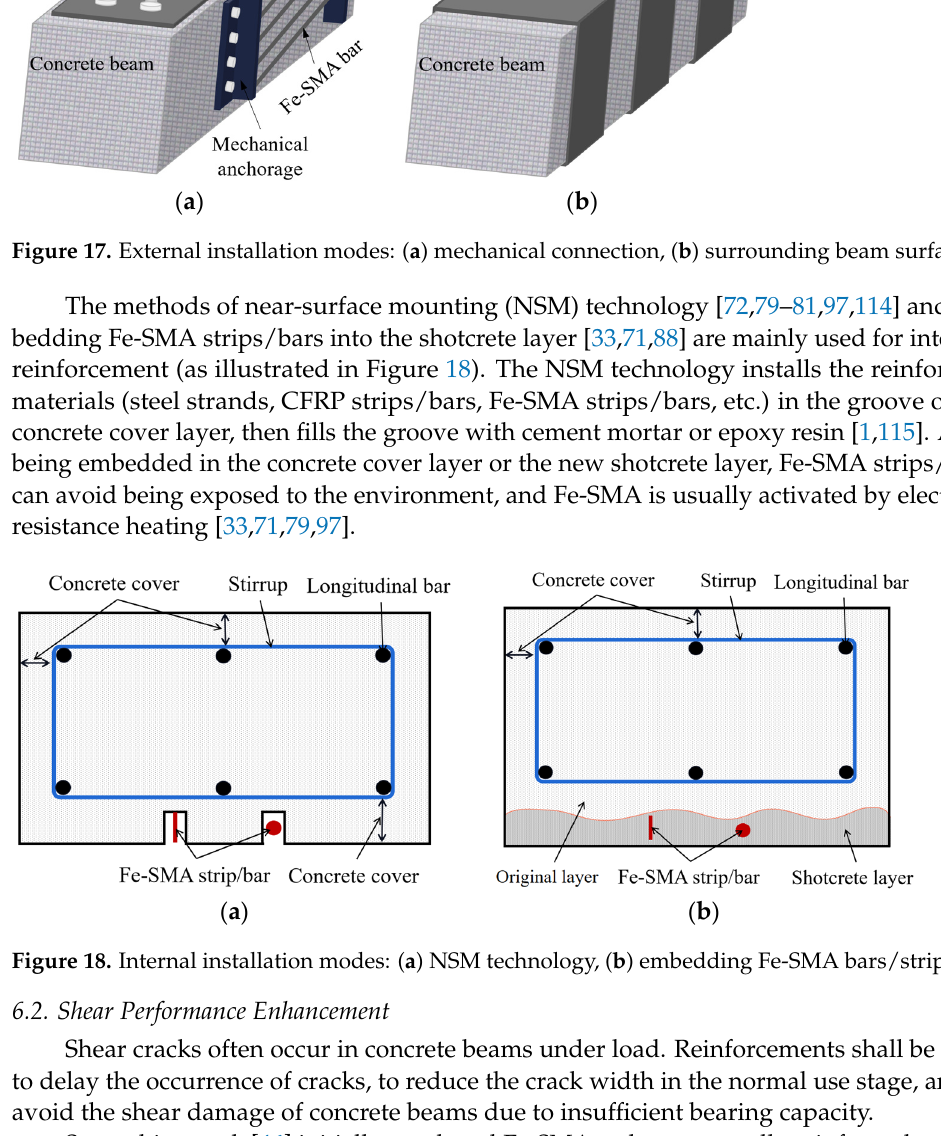
( f ) Figure 16. Repair process of the Fe-SMA plates covering crack–stop holes: ( a ) prestretch Fe-SMA plates, ( b ) locate crack tips, ( c ) polish the diaphragm, ( d ) bond the Fe-SMA plates, ( e ) activate the Fe-SMA plates, and ( f ) clean the diaphragm. 6. Reinforcement of Concrete Beams with Fe-SMA 6.1. Installation Method of Fe-SMA For concrete beams, external and internal reinforcement can be adopted to improve their mechanical performance such as improving flexural bearing capacity, repairing in- clined section cracks, and improving shear bearing capacity. For external reinforcement, installation methods such as bonding connection, an- chorage connection [46,80,97], nail–anchor connection [99], and surrounding beam surface